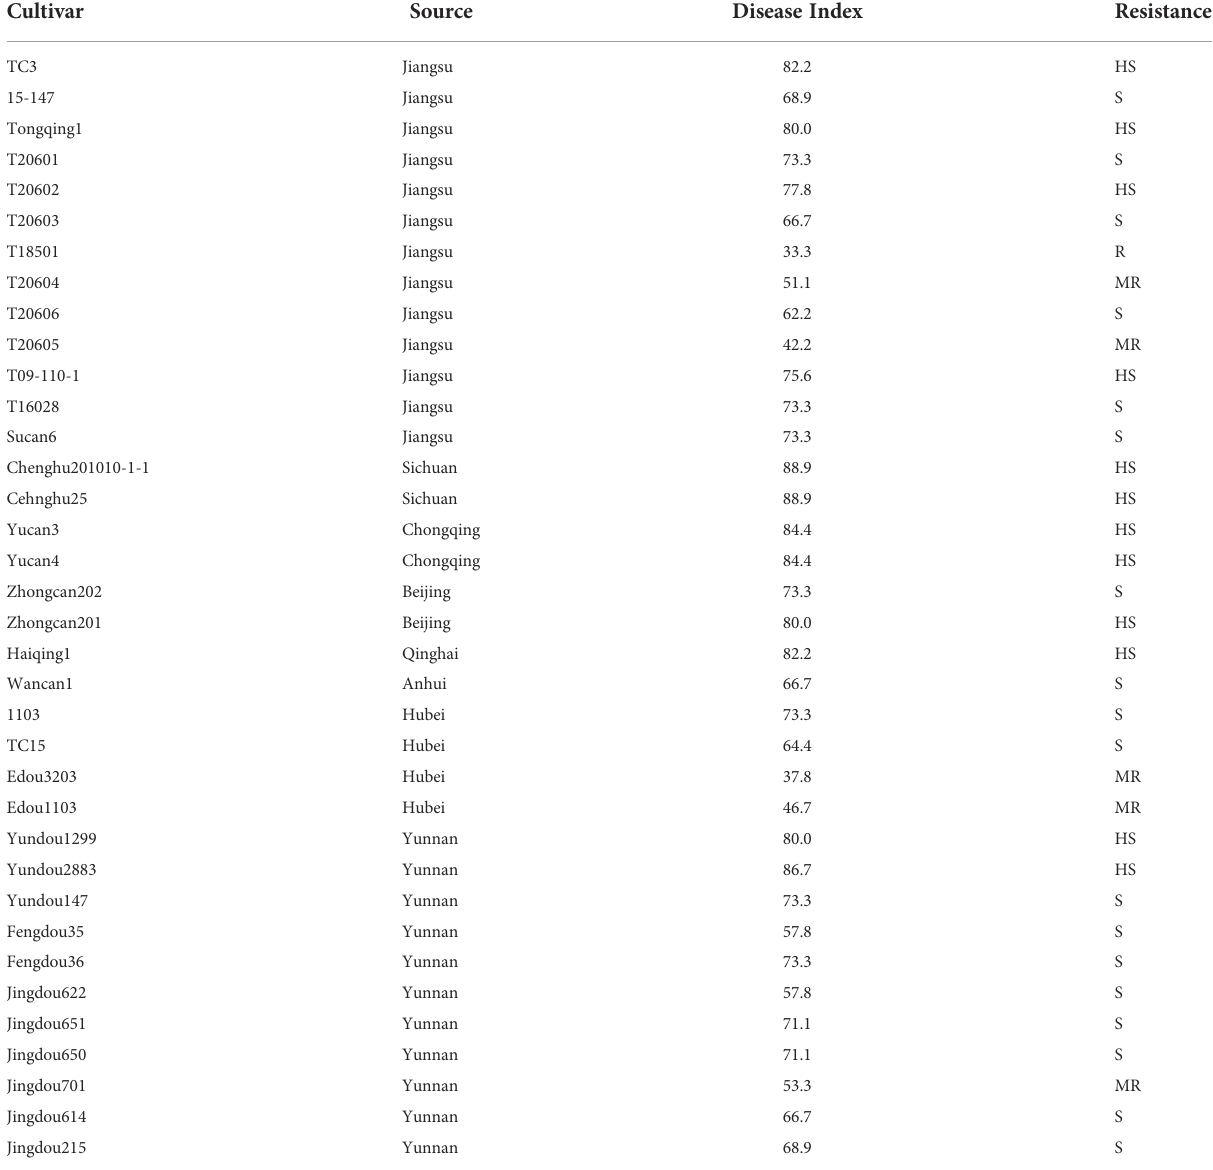
TABLE 3 Resistance identi fi cation of thirty-six faba bean cultivars to Berkeleyomyces rouxiae .